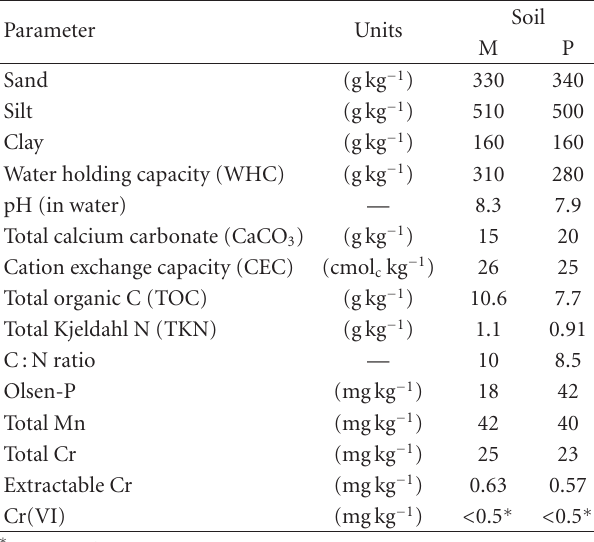
Table 1: Chemical characteristics of tannery land plaster (TLP). Parameter